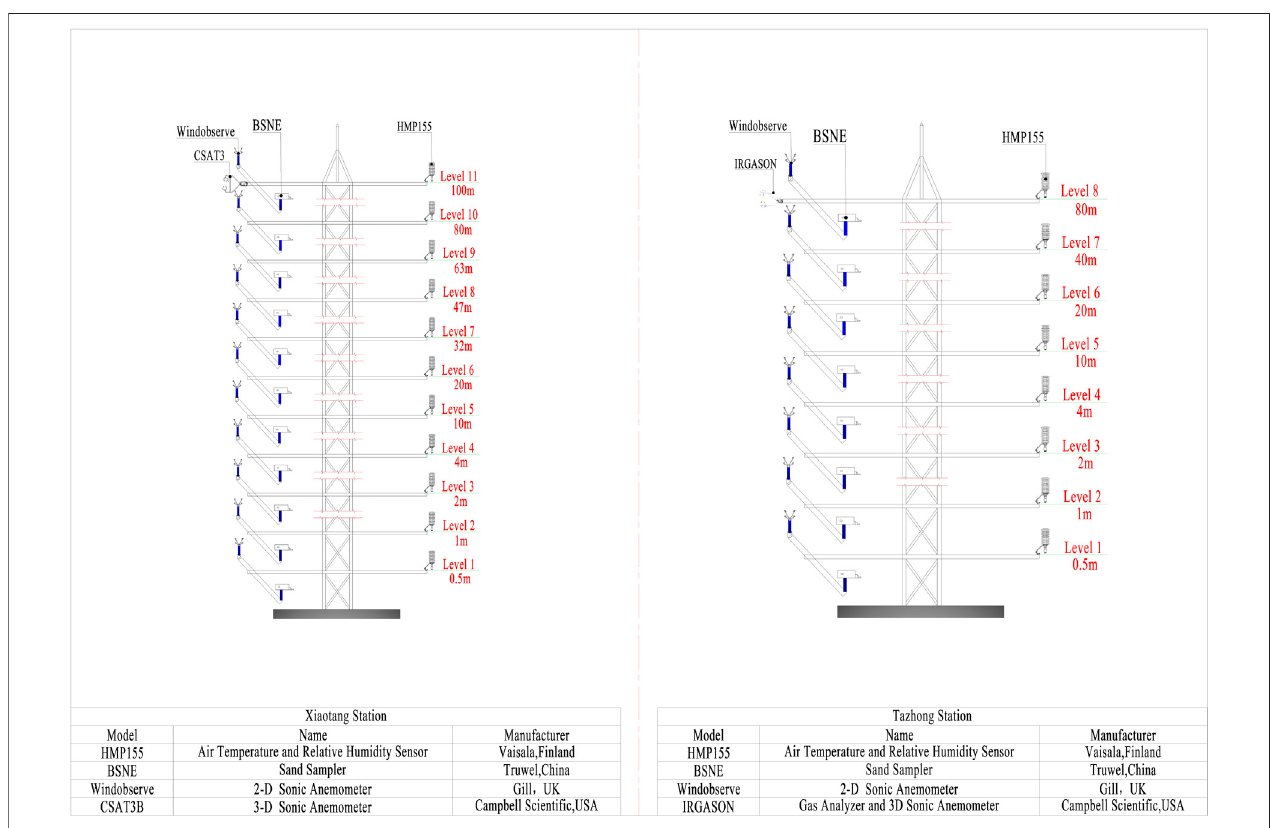
FIGURE 2 | Schematic of the fl ux observation systems in the Taklimakan Desert.